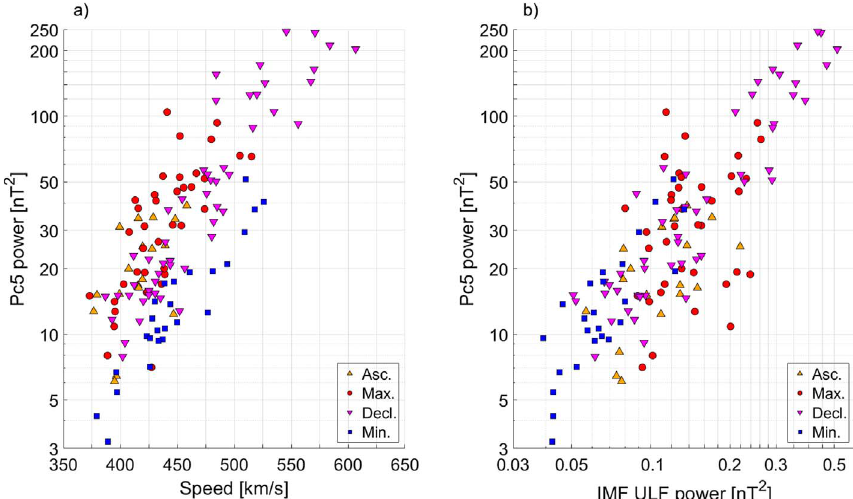
Fig. 2. Scatter plot showing U KEV in comparison to a) radial solar wind speed, b) U IMF , color-coded by the solar cycle phase.